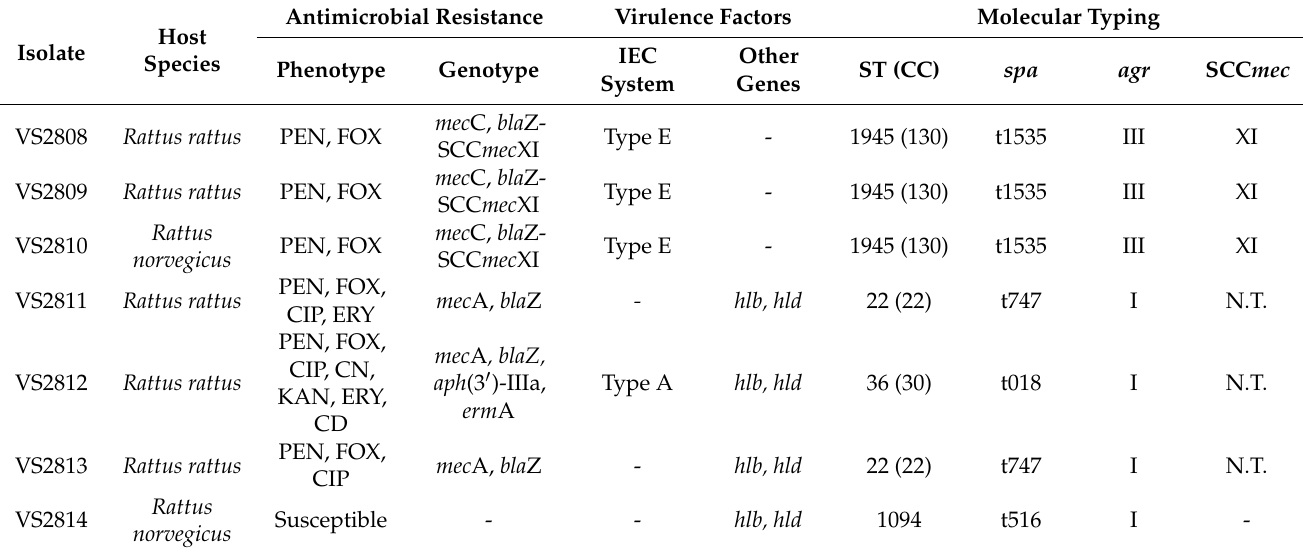
Figure 1. Number of samples collected from wild rodents captured in port areas of Lisbon and Ponta Delgada (S. Miguel island, Azores) and distribution of mec A- and mec C-MRSA in each location. Table 1. Characteristics of the MRSA and MSSA strains isolated from wild rodents in Portugal.